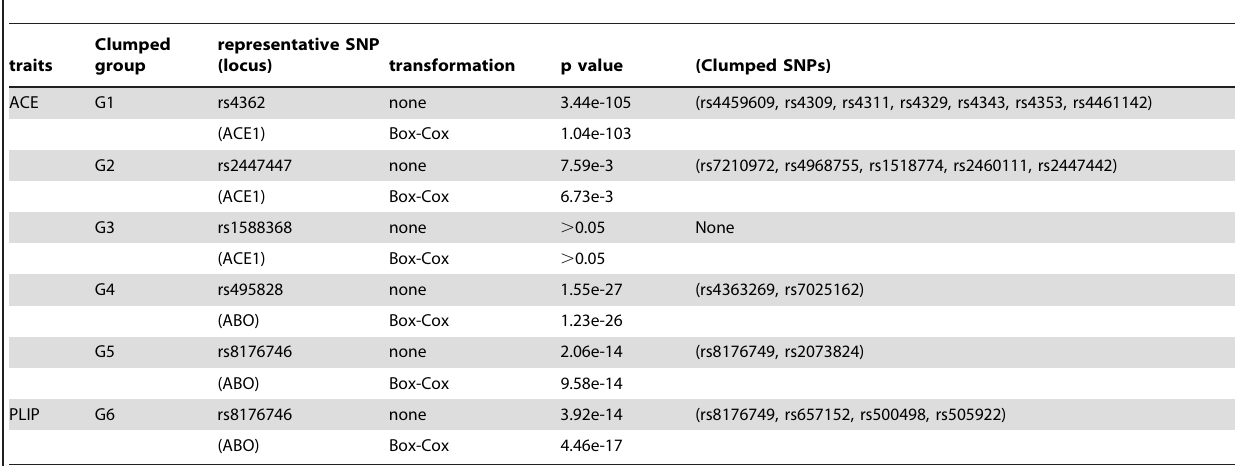
Table 4. Associations of clumped SNP groups with ACE and P-LIP in Takahata population.